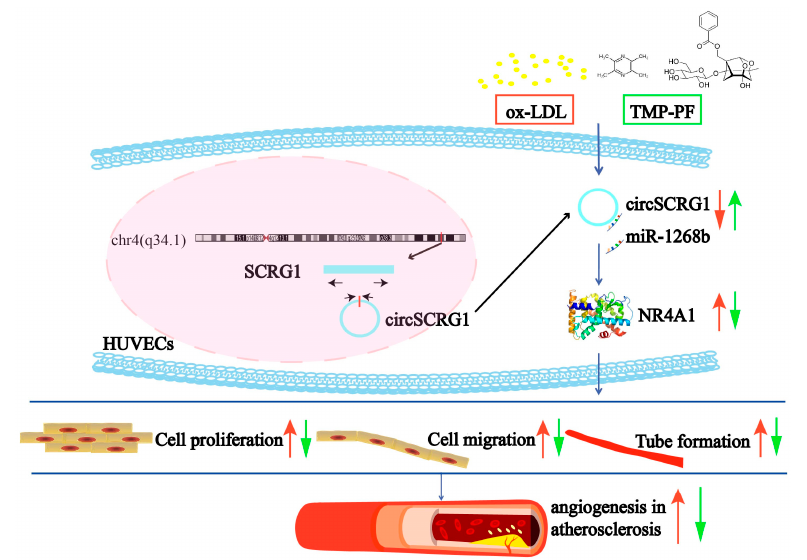
Figure 5. Schematic diagram showing the mechanisms of circSCRG1-mediated angiogenesis in atherosclerosis and the inhibitory effects of TMP-PF. Red arrows indicate the effects after ox-LDL induction, and green arrows indicate the effects after TMP-PF treatment.